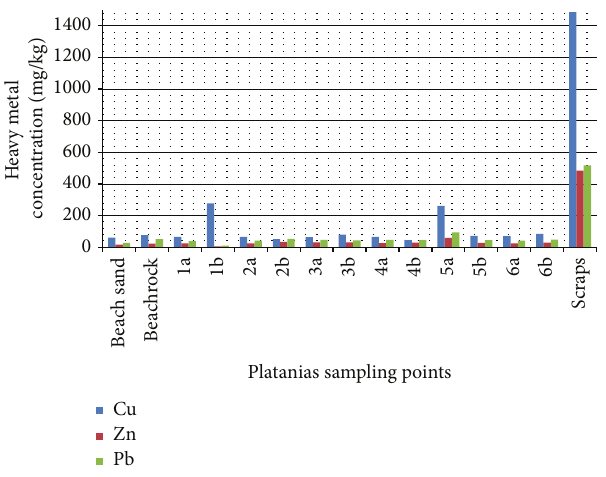
Figure 5: The results of the XRF analysis regarding Copper, Zink, and Lead of Platanias beach and